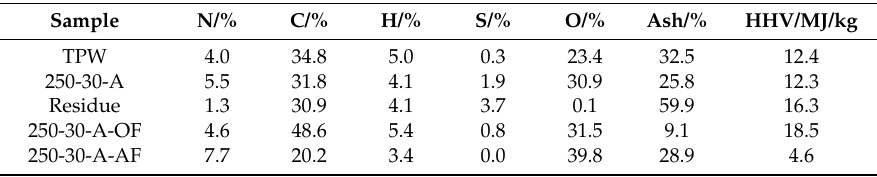
Table 6. Elemental composition, ash and HHV of HTL feedstock and products.